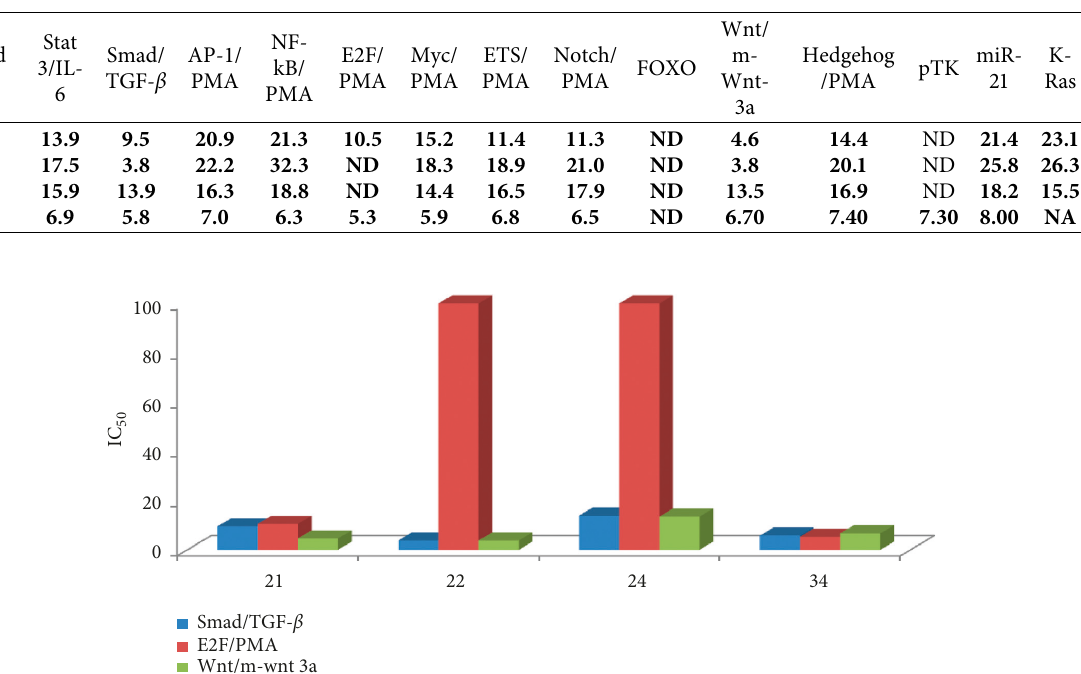
Figure 4: IC 50 [ μ M] of active isolated compounds against selected transcription factor signaling